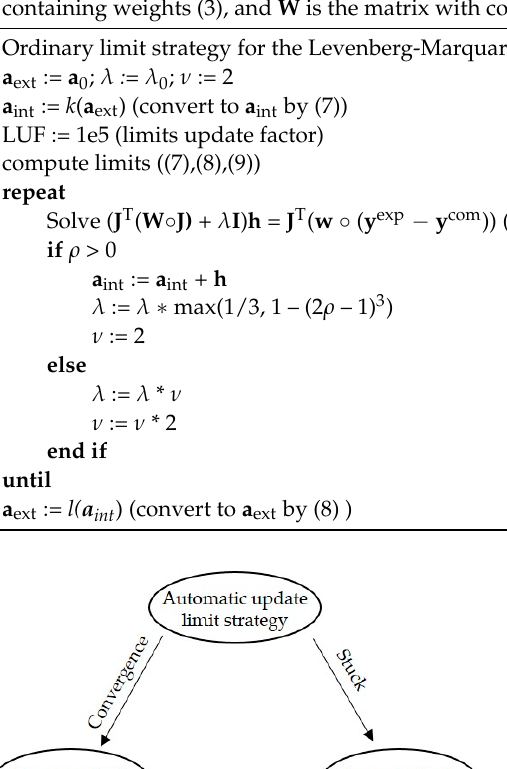
Algorithm 2. Pseudocode of Levenberg–Marquardt algorithm, which is coupled by the ordinary